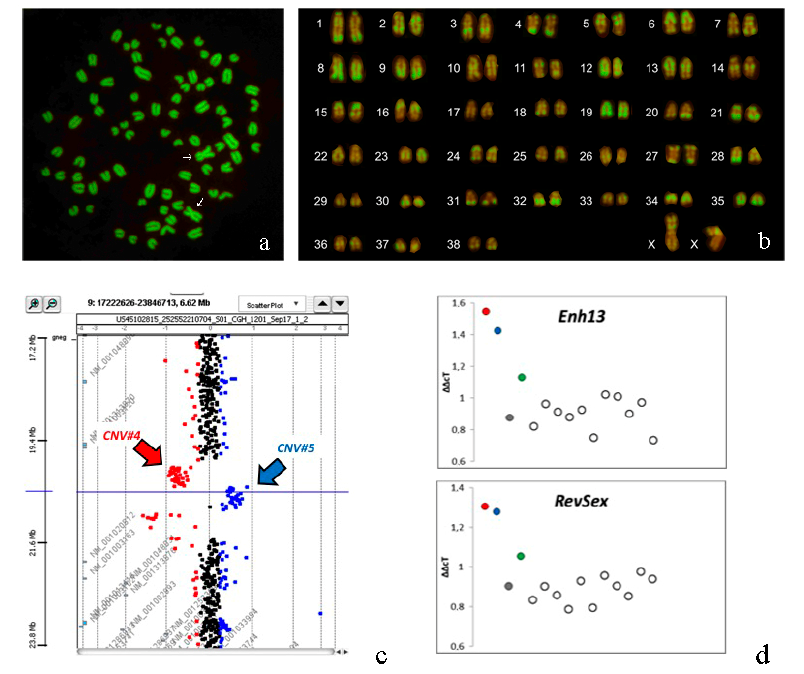
Figure 5. ( a ) Metaphase plate with 2 n = 78; XX of Case 3 (arrows indicate X chromosomes); ( b ) R-banding (RBA) karyotype of Case 3; ( c ) CGH-array profile regarding copy number variation (CNV) number 5 and 4 identified in Case 1 (Case 2 and 4 show the same CNV profile). The points above indicate the number of copies of the region tested. Black: region present in two copies; red region with fewer copies than normal (deletion); blue: region with more copies than normal (duplication). The x axis indicates the genomic position on chromosome 9 of the probes analyzed. The x-axis indicates the log ratio identified after the CGH analysis; ( d ) qPCR results for RevSex and Enh13 regions in the 4 cases and 11 controls. The dots show the comparative CT method ( ΔΔ cT) values obtained in the 11 control dogs and for the 4 DSD dogs (Case 1: red; Case 2: blue; Case 3: grey and Case 4: green).